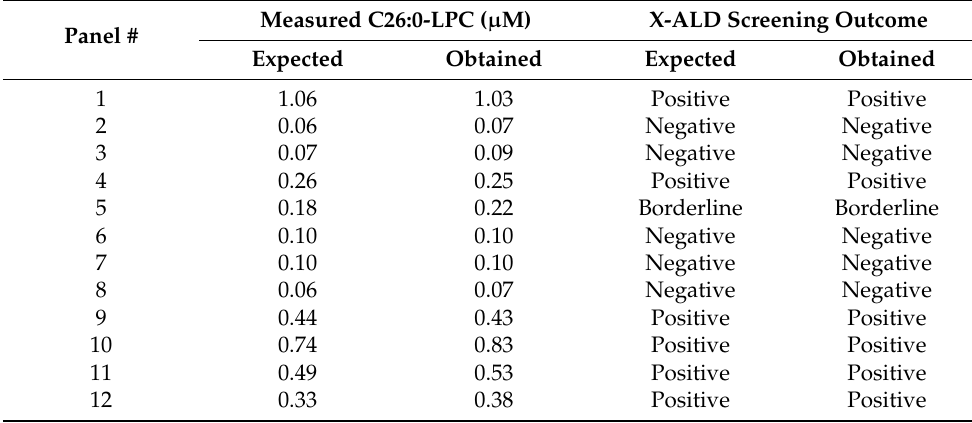
Table 3. C26:0-LPC concentrations and associated outcome from comparison